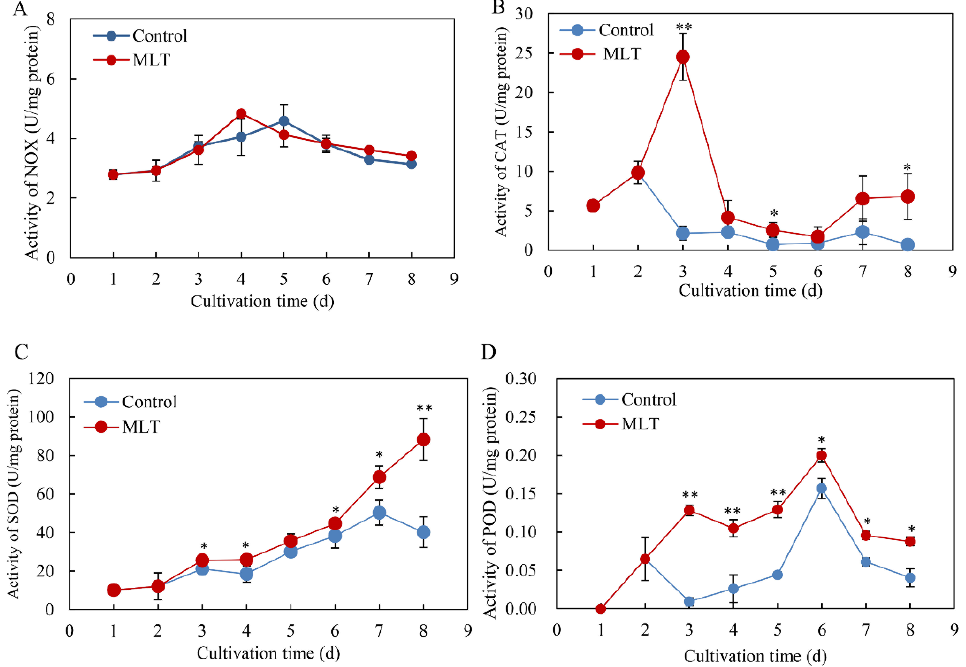
Figure 4. Effects of melatonin (MLT) on enzyme activities of NADPH oxidase (NOX) ( A ), catalase (CAT) ( B ), superoxide dismutase (SOD) ( C ), and peroxidase (POD) ( D ) in the mycelia of Shiraia sp. S9 in liquid culture. The culture was maintained in a 150 mL flask containing 50 mL medium at 150 r/min and 28 °C under a light/dark shift (24 h:24 h) for 8 days. MLT at 100.00 μ M was added on day 2 of the culture. Values are mean ± SD from three independent experiments. (* p < 0.05 and ** p < 0.01 vs. control).